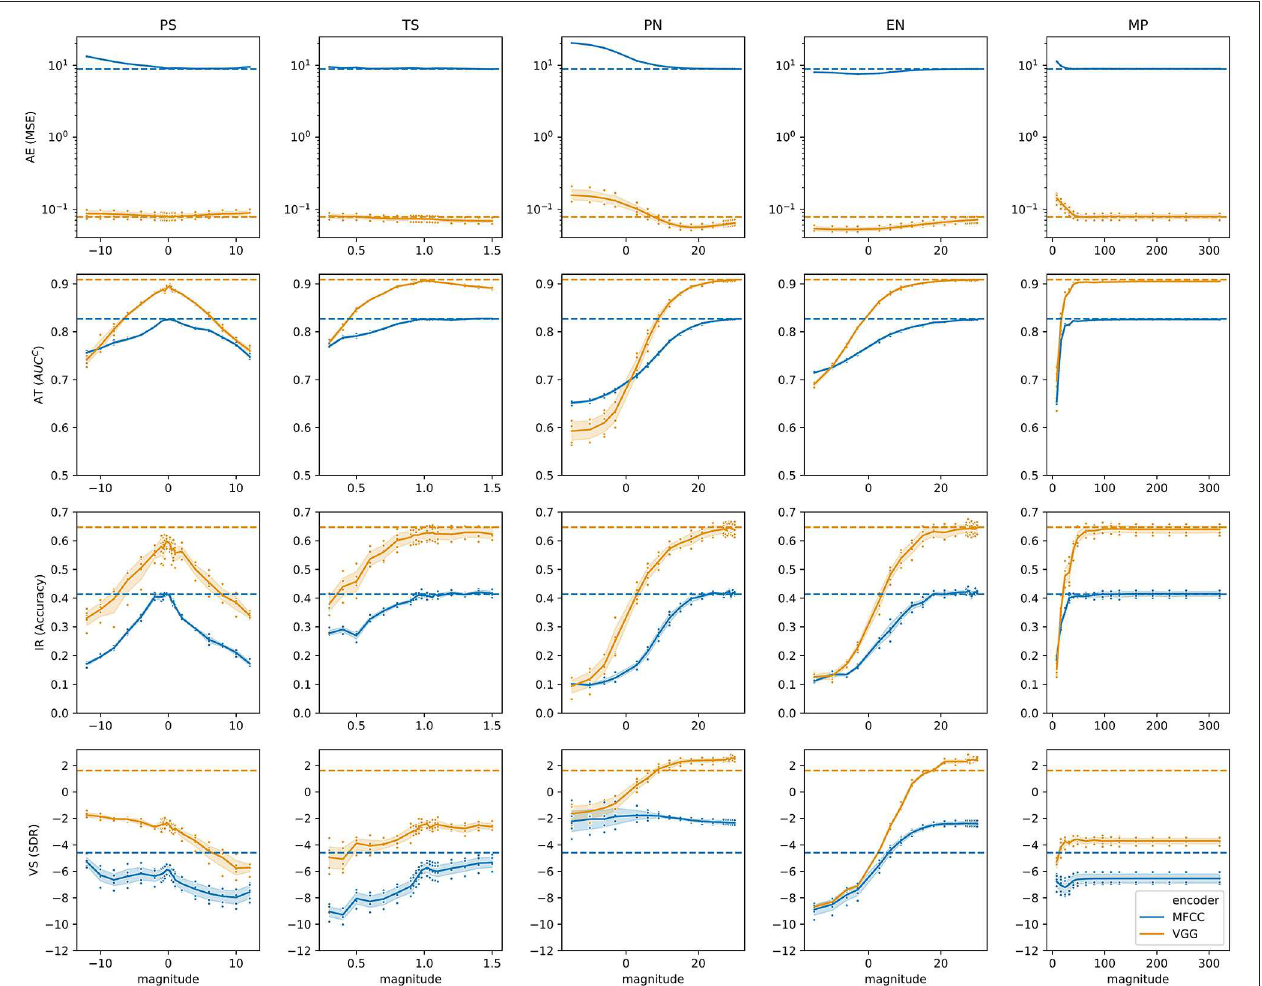
FIGURE 4 | Task specific performance results. Blue and yellow curves indicate the performance of different encoders for each task, over the range of magnitude with respect to the transformations. The performance of original samples is indicated as dotted horizontal lines. For the remaining of the paper including this figure, all the confidence intervals are computed with 1,000 bootstraps at the 95%